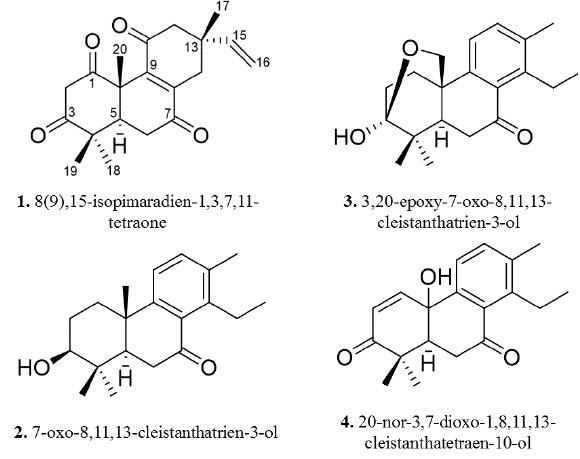
Figure 2. Chemical structures for compounds 1 – 4 .